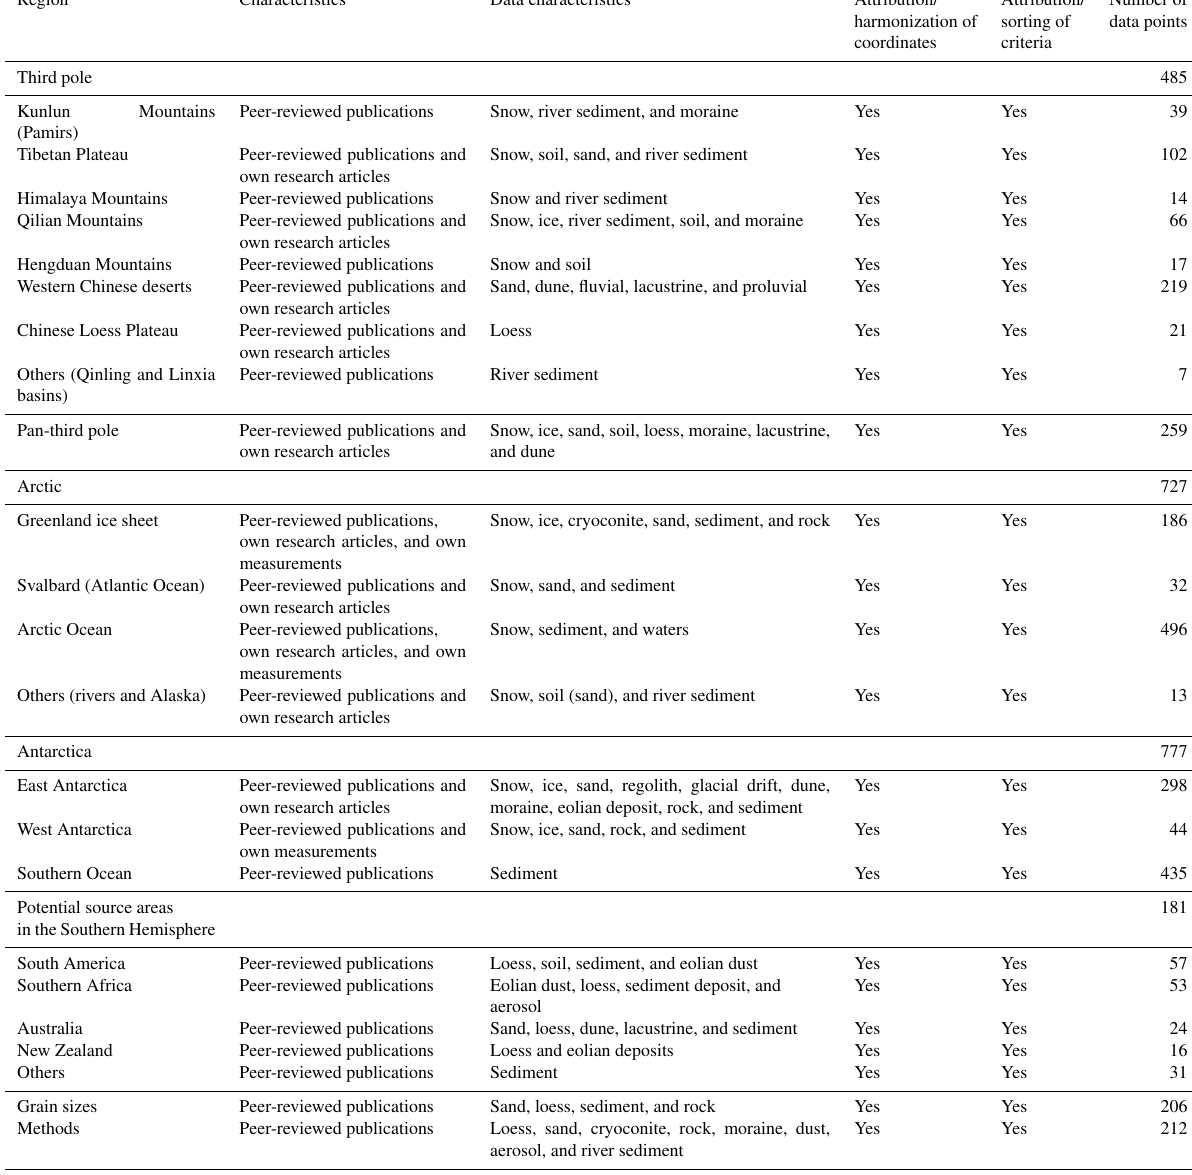
Table 1. Data distribution locations and sample types for 87 Sr / 86 Sr and ε Nd (0) from 90 references.